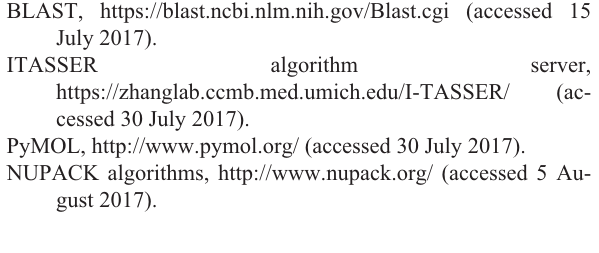
Figure S1 – Structural models of the chimeric